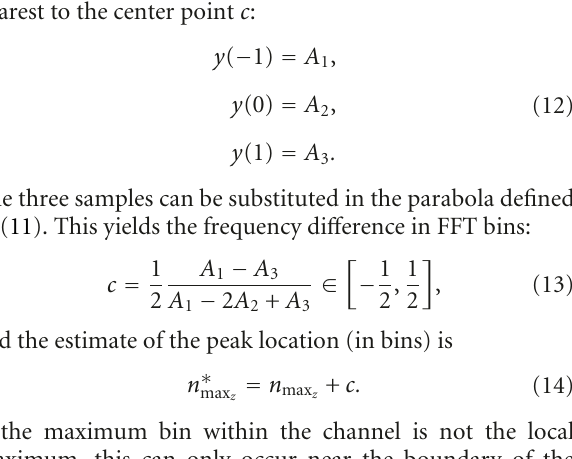
system centered at n max is defined. e ( n max − 1) and e ( n max +1) represent the energy of the two adjacent bins. By taking the energies in dB, we